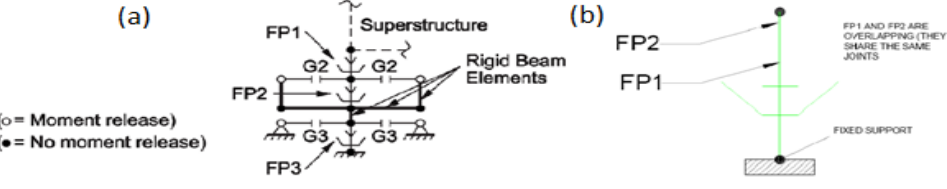
Figure 14. ( a ) Series model of the MSCF sliders [45]. ( b ) Parallel model developed for representing special configuration of the MSCF sliders [51].